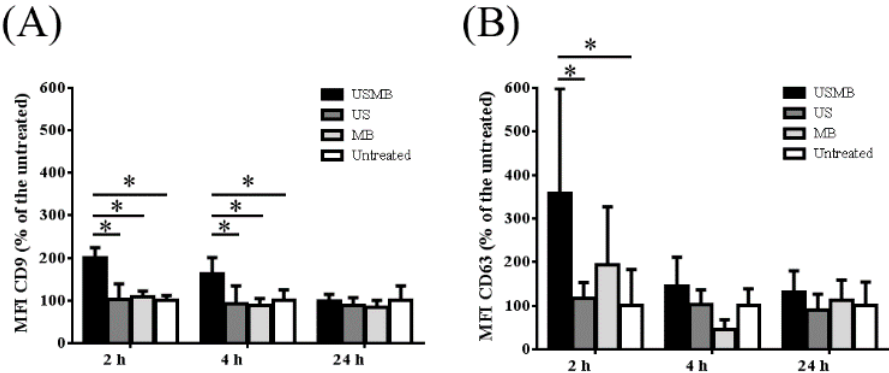
Figure 1. Comparison of the level of mean fluorescence intensities (MFI) of bead-captured extracellular vesicles (EVs) exposing CD9 and CD63 measured using flow cytometry. MFI CD9 and MFI CD63 were corrected from their IgG1 controls. Percentages of MFI CD9 ( A ) and CD63 ( B ) of EVs derived from conditioned media of FaDu cells collected at 2, 4 and 24 h after microbubbles-assisted ultrasound (USMB), ultrasound (US), and microbubbles (MB) treatments were calculated by comparing those with the untreated counterparts. Bars represent mean of three independent experiments + standard deviation. Statistical analysis was performed using two-way ANOVA followed by Tukey’s test. p value < 0.05 was considered significant (*).